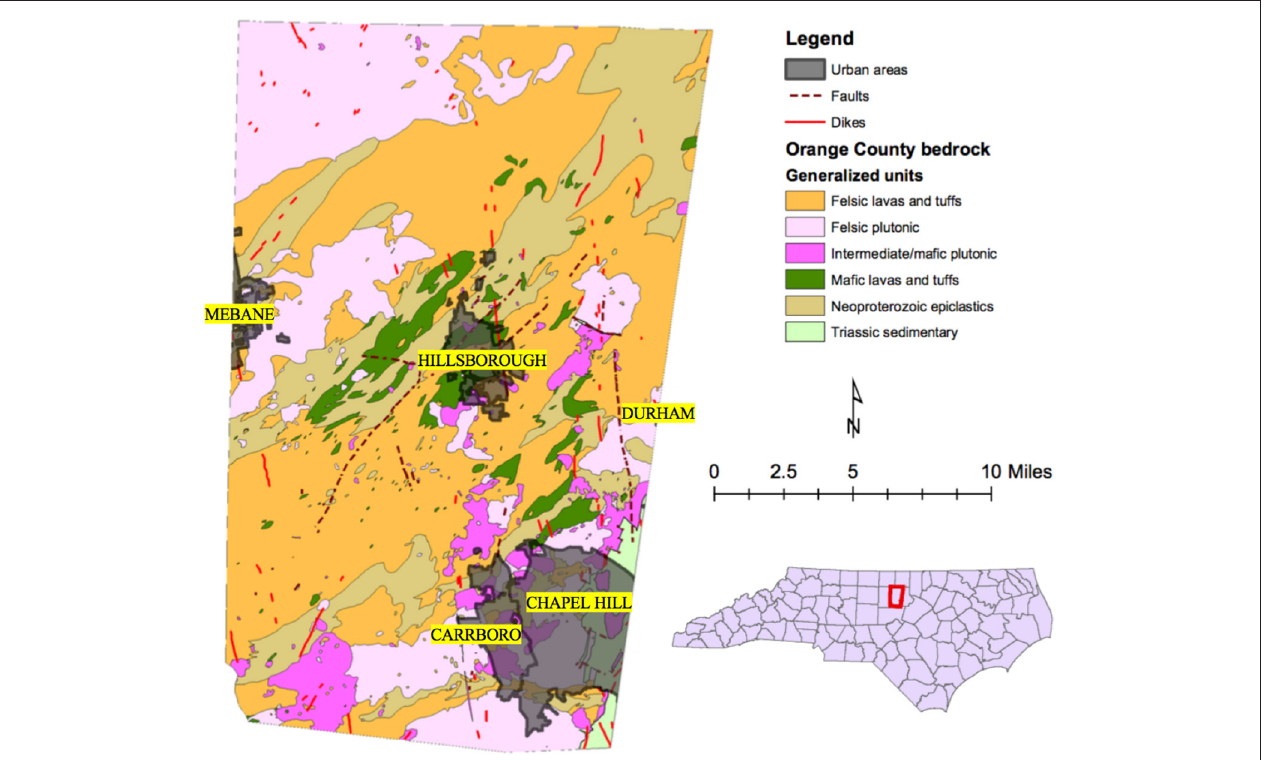
FIGURE 1 | Map of Orange County, North Carolina showing the geology of the county and municipalities located in the county. Inset is a map of North Carolina with Orange County outlined in red.